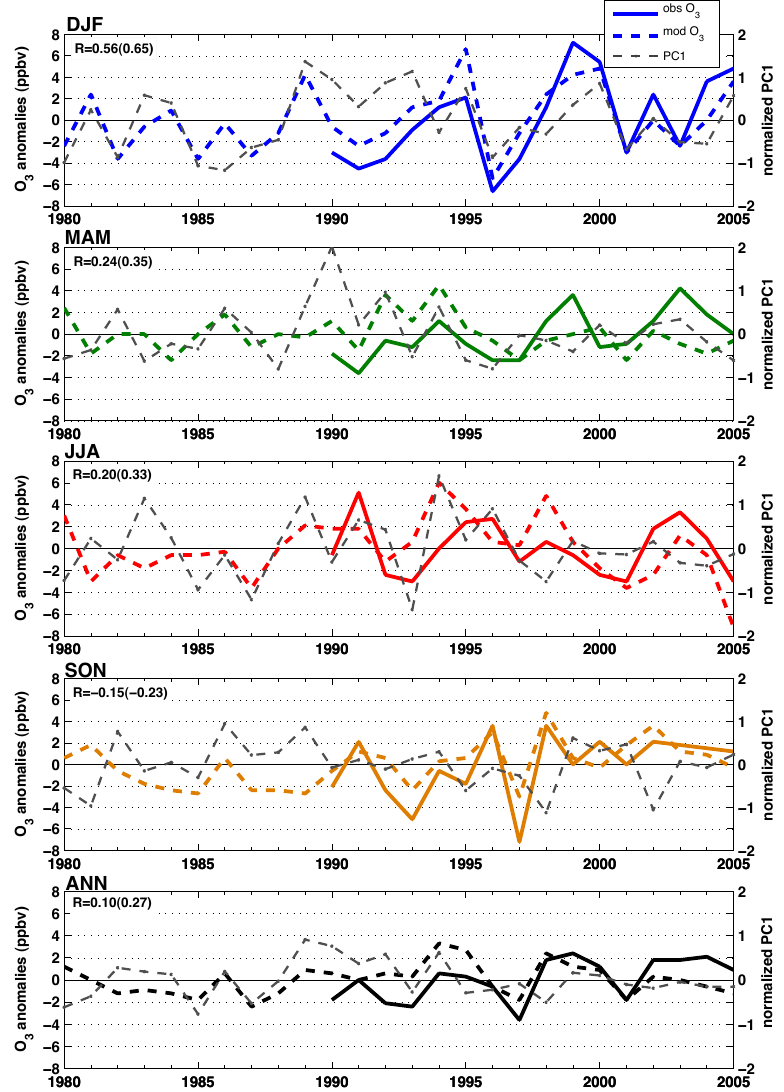
Fig. 12. Modelled (dashed lines) and observed (solid lines) surface O 3 mixing ratio trends at Mace Head for each season and the annual mean. The gray dashed line displays the normalized seasonally averaged PC1 timeseries. Bold numbers in the upper left corners show the correlation between PC1 and observed and modeled (in brackets) O 3 mixing ratios. The correlations are significant at 90% confidence level when higher than 0.41 for observed O 3 /PC1 correlation and 0.32 for modeled O 3 /PC1 correlation.